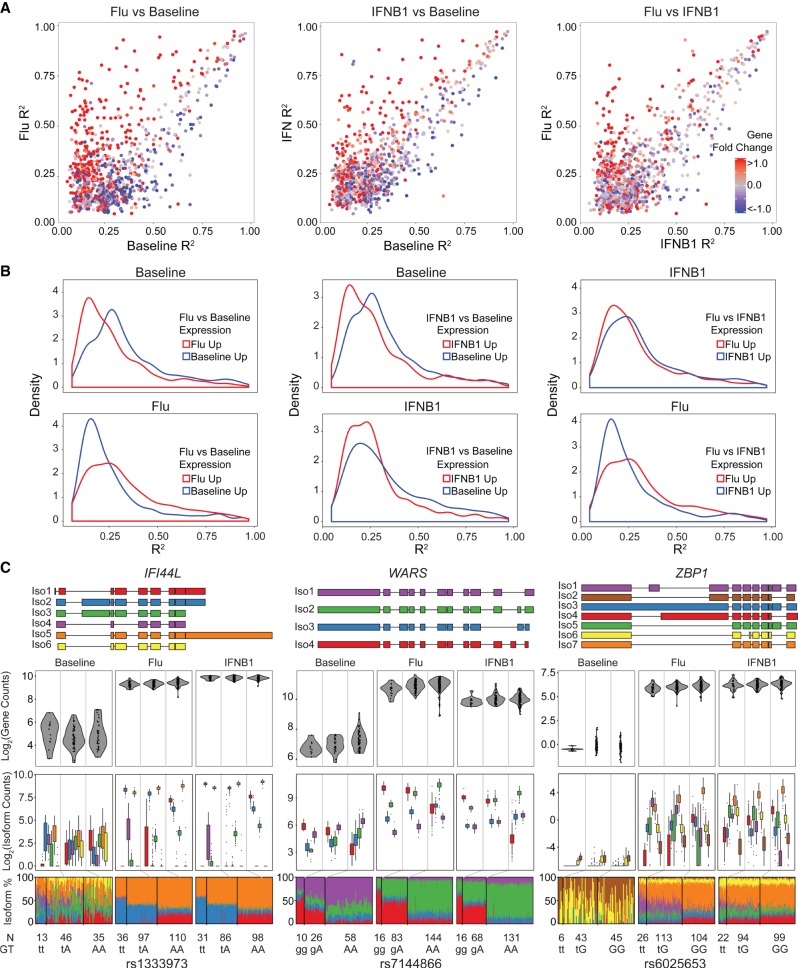
Comparison of local isoQTLs between conditions. (A) Correlation of effect sizes (R2) for significant local isoQTLs (permutation FDR < 0.05) between pairs of conditions. Transcripts are colored by differential expression (red indicates up-regulated in condition 2, y-axis; blue indicates up-regulated in condition 1, x-axis) for each pair of conditions. (B) Distributions of effect sizes (R2) for significant local isoQTLs (permutation FDR < 0.05) for each pair of conditions segregating genes based on expression in each condition. (C) De novo constructed transcript structure (top) and box-whisker plots (bottom three panels) between transcript quantitative traits (y-axis: log2(normalized gene abundance), log2(normalized isoform abundance), or isoform usage percentage) and genotype (x-axis) for three genes (IFI44L, WARS, and ZBP1) with risoQTLs.